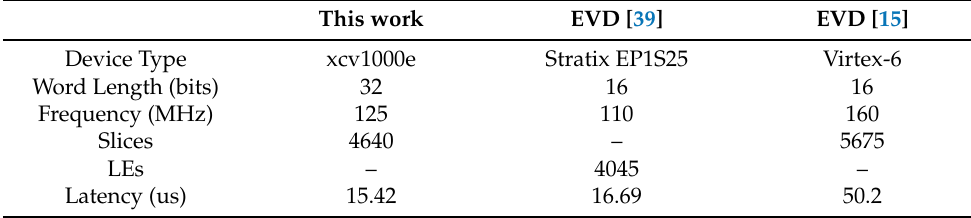
Table 7. Performance comparison of our design and selected previous pieces of research. This work EVD [39] EVD